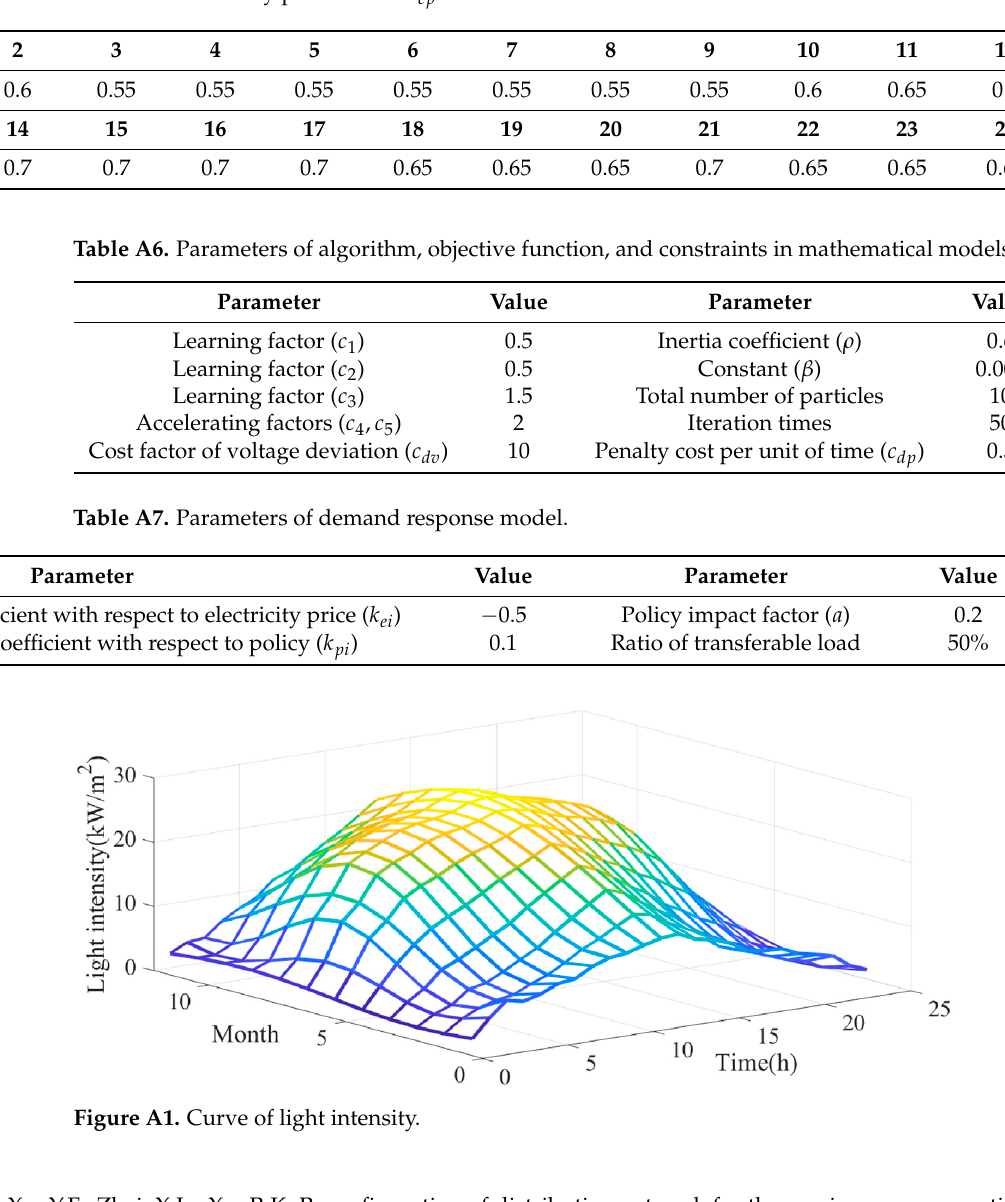
Table A5. Electricity price in 24 h c t ep .